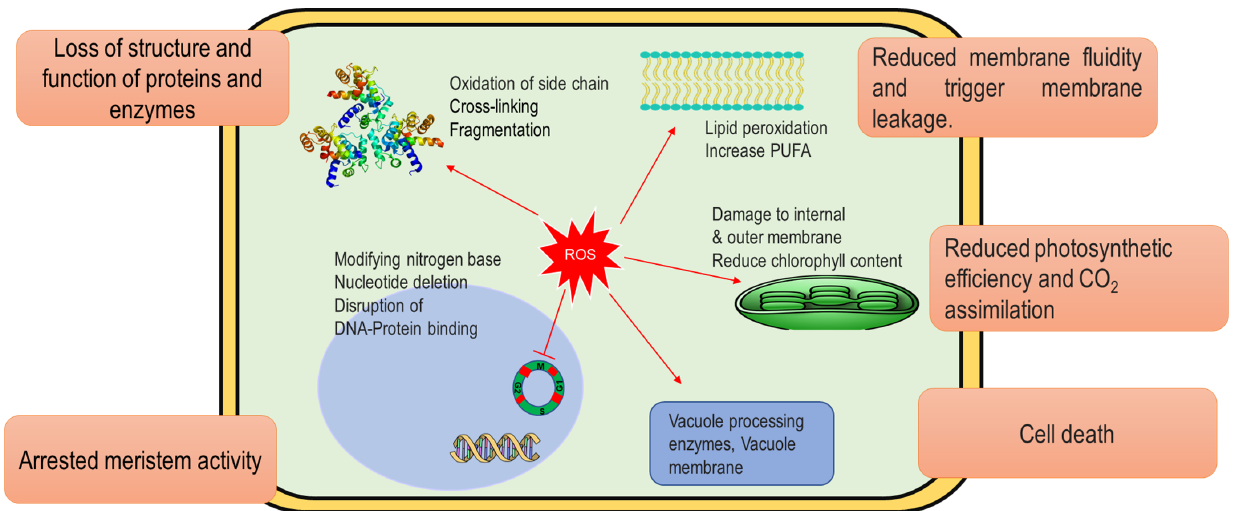
Figure 4. Detrimental effects of reactive oxygen species on cellular component and their consequences (rectangle box, outside the cell) under arsenic stress.